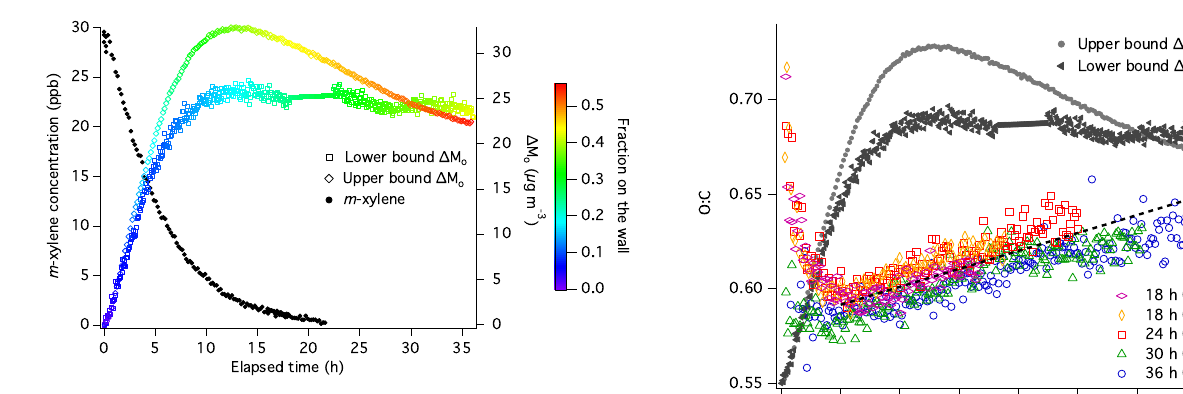
Fig. 2. SOA mass (right axis), corrected for particle wall losses, and m -xylene (left axis) for 36 h of OH exposure using AS seed. The lower bound 1M o is calculated assuming that, once deposited, particles on the walls do not interact with gases in the chamber. The upper bound 1M o assumes that, once deposited, particles continue to exhibit the same gas-particle partitioning behavior as suspended particles. The fraction on the wall for the lower bound is the ratio of particle volume on the wall to total particle volume, both suspended and deposited, and includes seed volume. The fraction on the wall for the upper bound is the ratio of organic mass concentration on the wall to the total organic mass concentration.